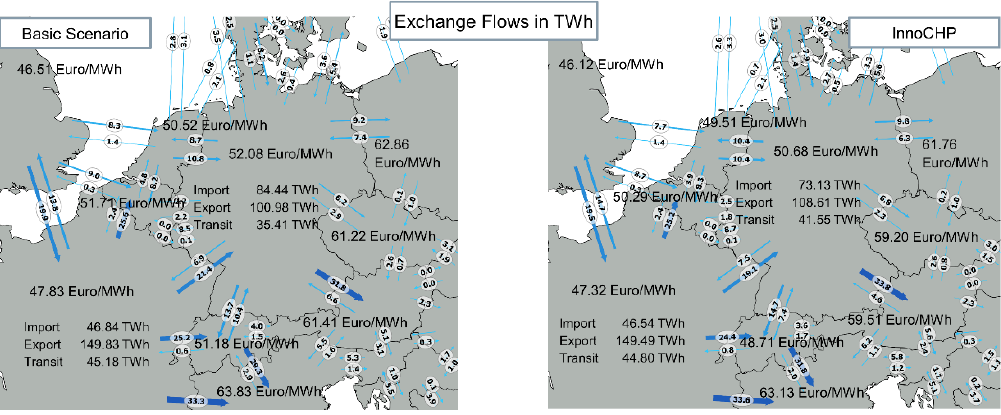
Figure 7. Market model results: Comparison of annual energy exchange in 2035 between countries and the average electricity price for the base scenario on the left and the InnoCHP on the right.